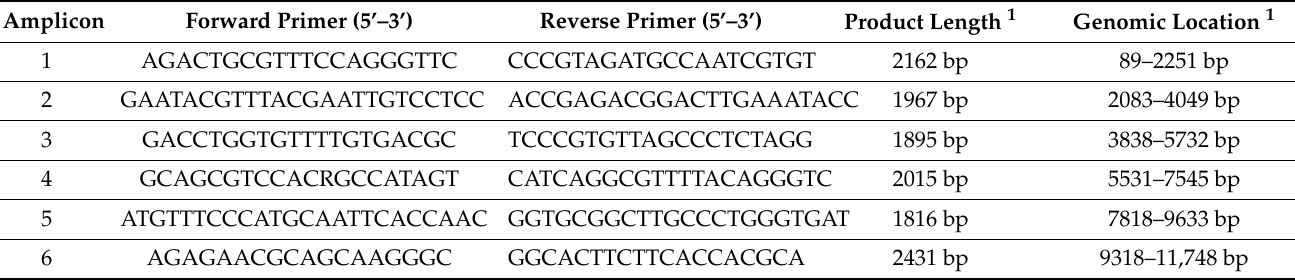
Figure 2. Visualization of steps used in this study generate nanopore sequencing data spanning the SAV genome. See Methods (Sections 2.1–2.3) for full details. Table 1. Primer sequences used to amplify SAV genomic regions that were nanopore sequenced.